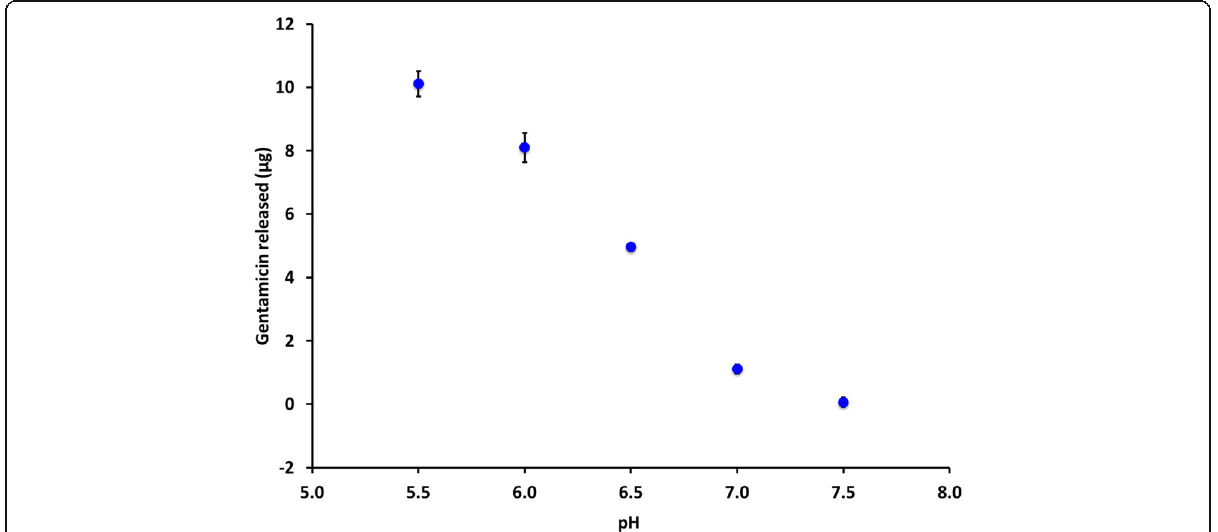
Fig. 7 Amount of gentamicin released from a tannic acid/gentamicin multi-layer construct, into phosphate buffer solutions of various pHs. Error bars smaller than the data-point bullets are not